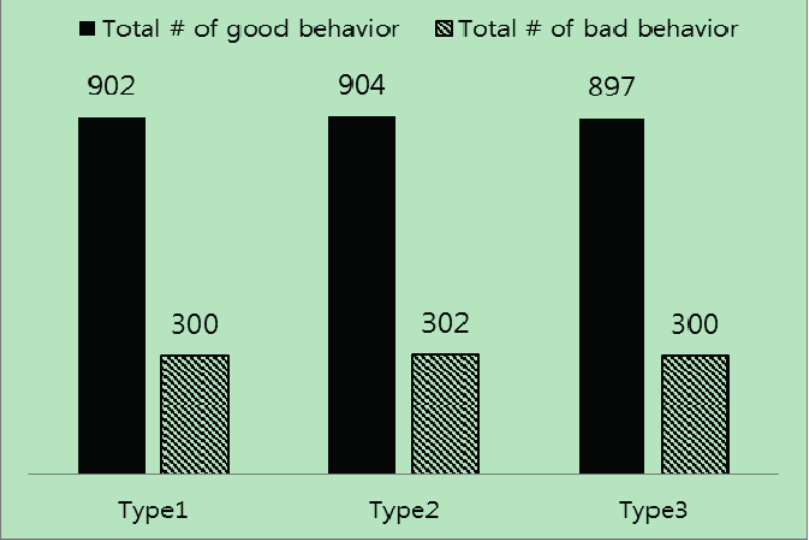
Figure 12. Total incidents of good and bad behavior in three types of on-off